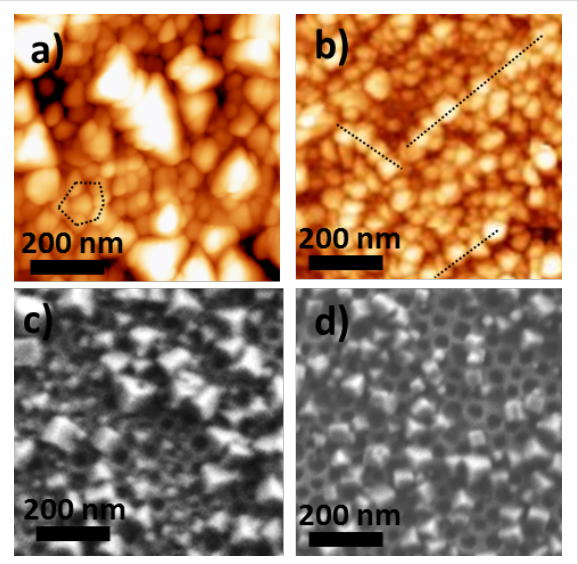
Figure 10: AFM images of a) NC04 , b) NC05 and SEM micrographs of c) NC04 , d) NC05